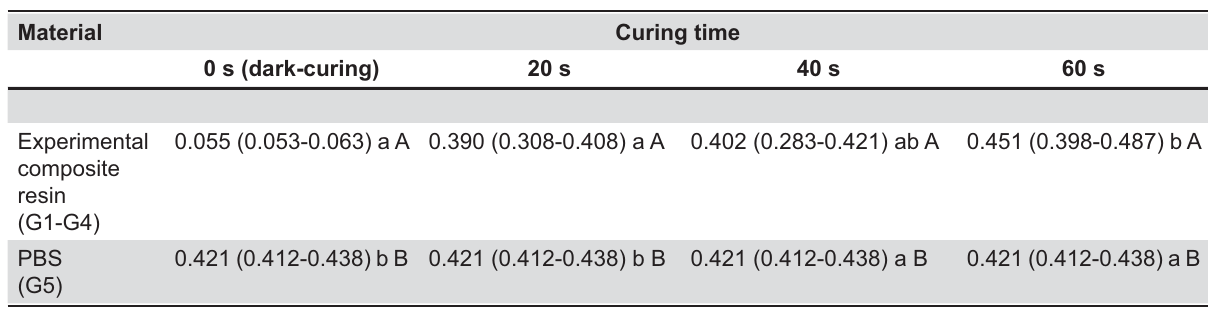
Table 1- SDH enzyme activity of the odontoblast-like cells (MDPC-23) detected by the MTT assay as a function of the curing time